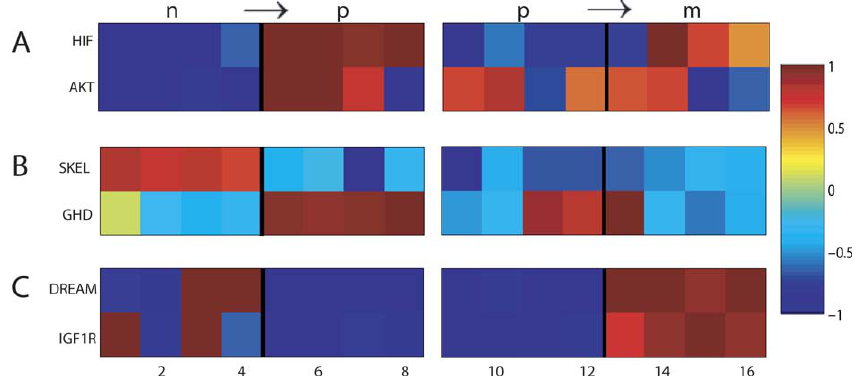
Figure 4. Enrichment Scores of the Two Highest Ranked Gene Sets from RML (A) f n a p a m g . (B) f n a p g . (C) f p a m g . See Figure 1 for further details and Table 7 for full pathway names.